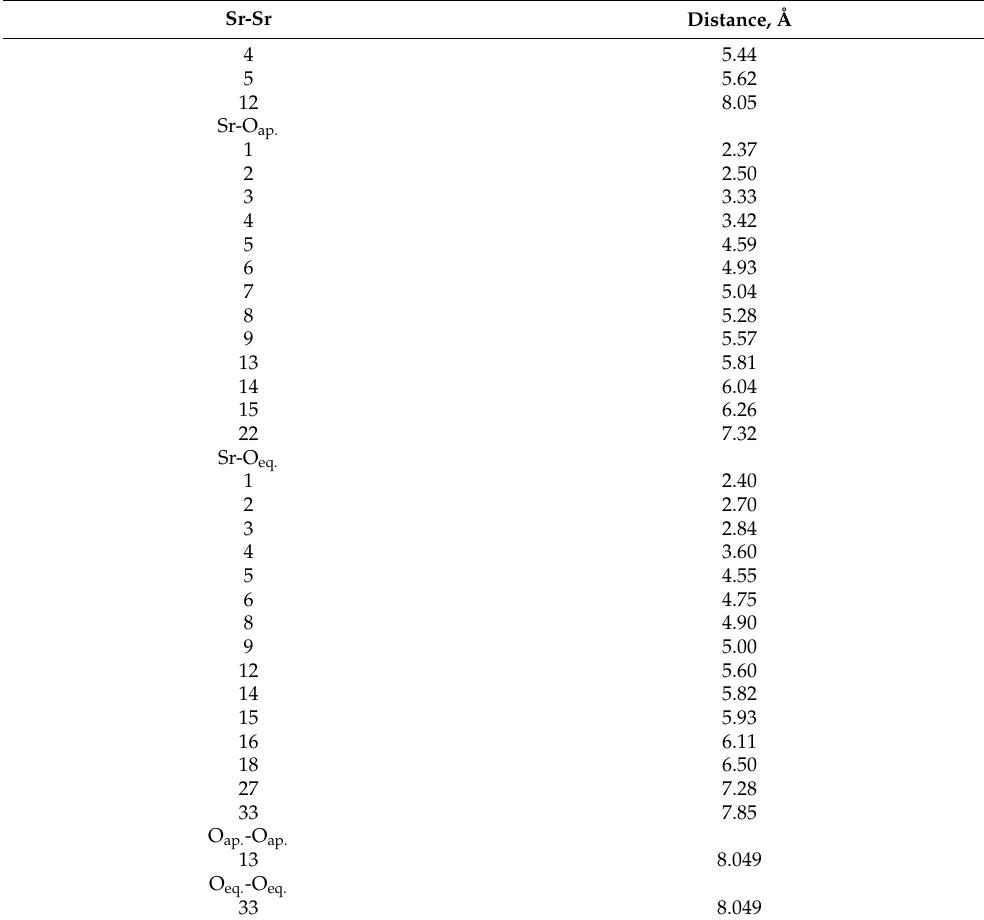
Table A2. Radial Distribution Function of Sr-Sr, Sr-O apical , Sr-O equatorial , O apical -O apical , and O equatorial -O equatorial